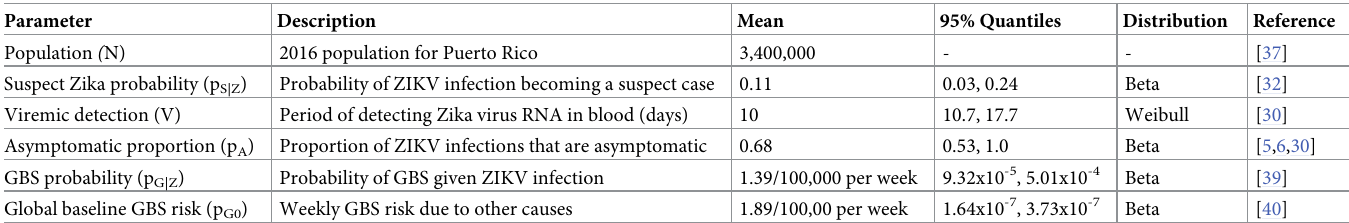
Table 3. Model parameters and prior